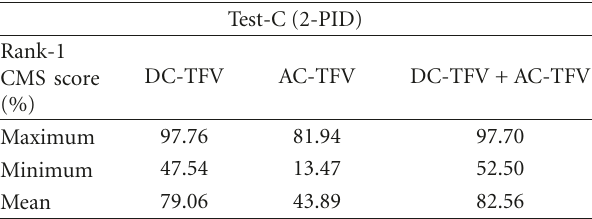
Table 3: Results of using two